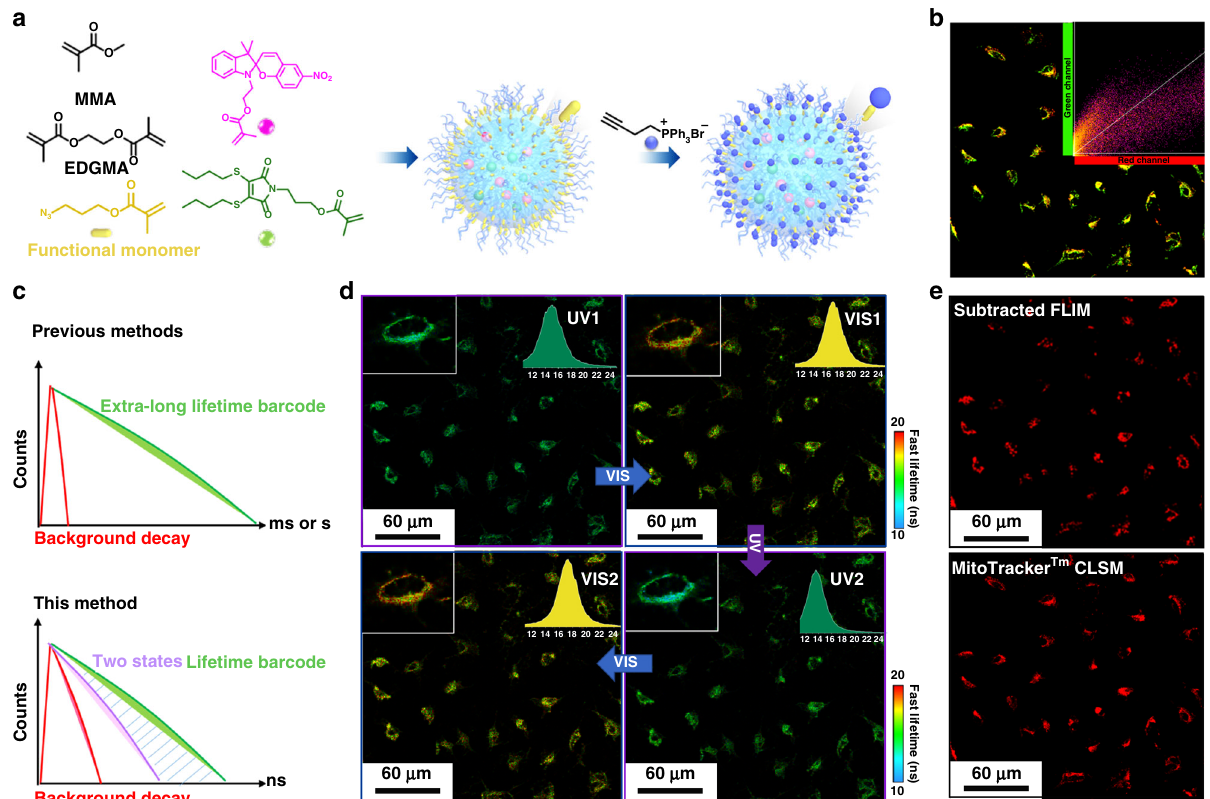
Fig. 4 Functionalized photo-switchable nanogels for lifetime imaging in living cell. a Schematic illustration of the nanogel functionalization strategy and post-polymerization modi fi cation strategy for mitochondria tracking. b Confocal images of co-localized nanogel (TPP-N6, green channel) with MitoTracker Red (Red channel) in live A549 cells. Green channel: the ring-opened form of SP ( λ ex. = 405 nm); Red channel: MitoTracker Red ( λ ex. = 630 nm). The intensity correlation plots of TPP-N6 and MitoTracker Red were processed on imageJ and Pearson correlation coef fi cient was analyzed using Coloc2 plugins; c Schematic illustration of the lifetime ampli fi cation strategy using the reversible method compared with the previous method which required extra-long lifetime. d FLIM images of the nanogel with mitochondria tracker (TPP-N6) in live A549 cells under the stimulation of remote UV and Vis manipulation (Irradiation time: 120 s). Similar images were obtained for more than two sets of experiments. The insert images are the lifetime histograms of the nanogel in the whole image; Scale bar: 60 μ m; Color bar: Fast lifetimes (ns). e The FLIM image (top) of TPP-N6 in live A549 cells before UV irradiation was subtracted with the same range after UV irradiation calculated by ImageJ. The subtracted image (top) was compared with the confocal fl uorescence (bottom) of MitoTracker Red (Red